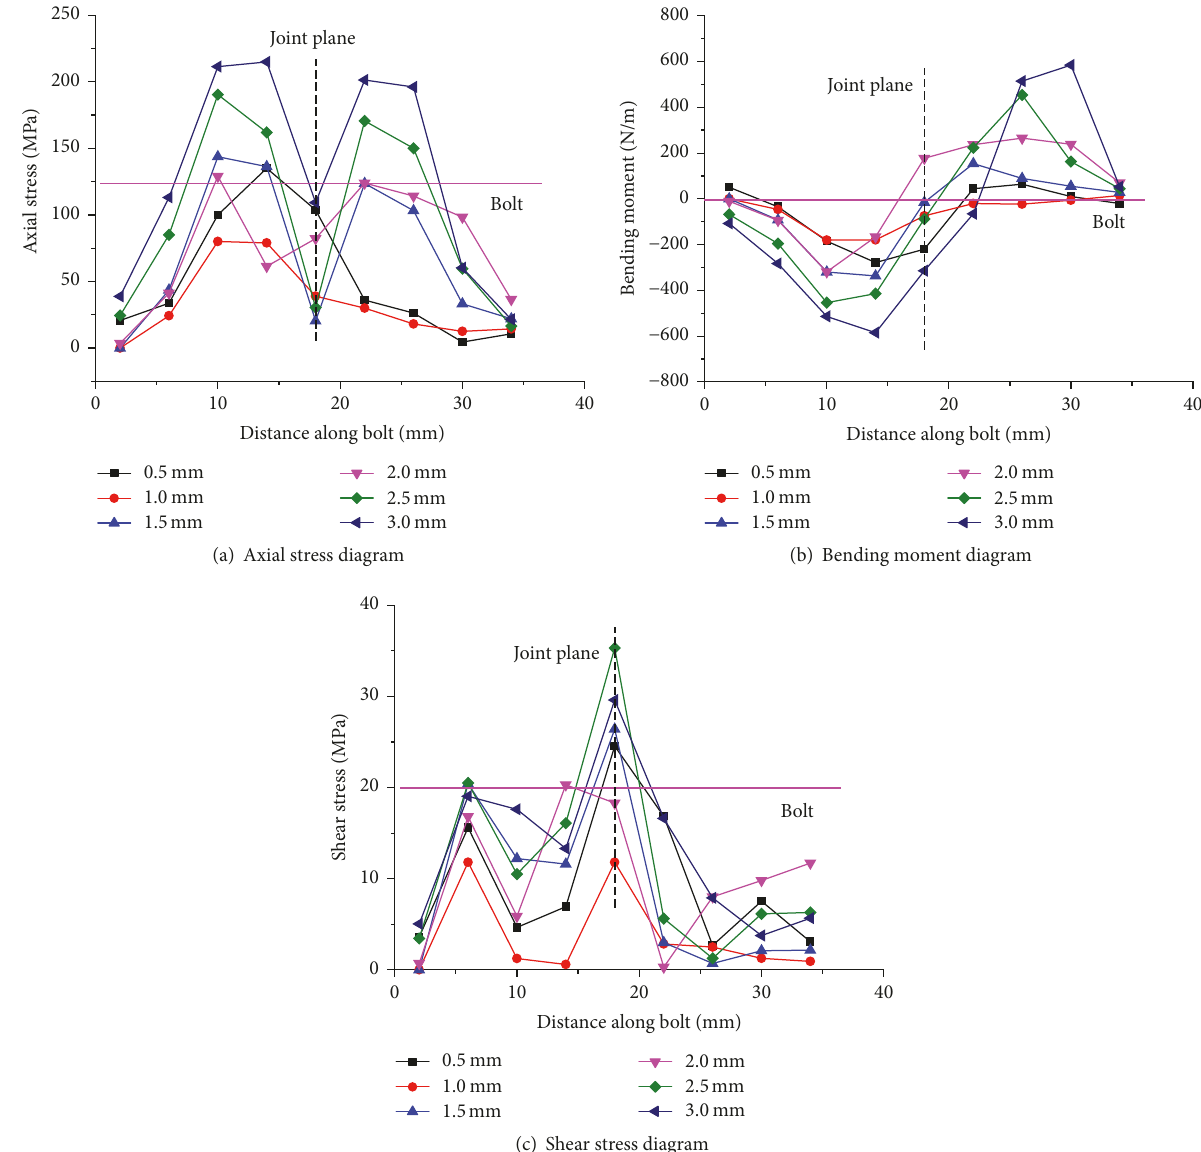
Figure 11: Bolt stress state diagram at an anchorage angle of 90 ∘ .